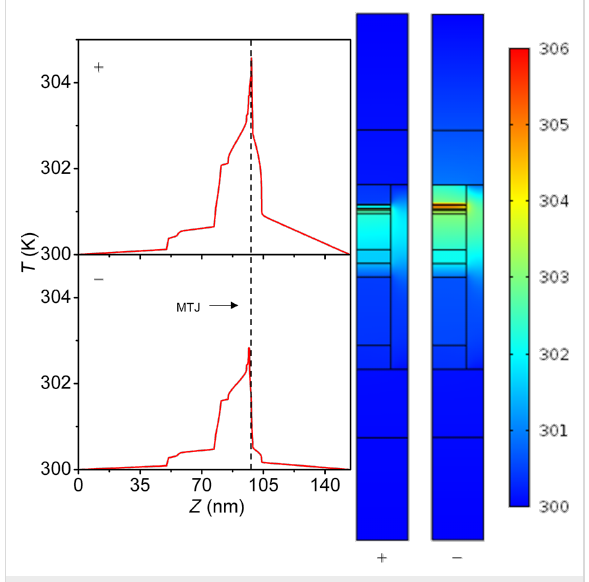
Figure 5: Thermal profiles of configuration II with SiO 2 passivation with an applied voltage of 0.3 V in “positive” polarity (top) and “negative” polarity (bottom). Left figures show the temperature as a function of the vertical position with 0 nm being the bottom of the device. The dotted line in the plots represents the center of the MTJ. Note the asymmetry around the MTJ.